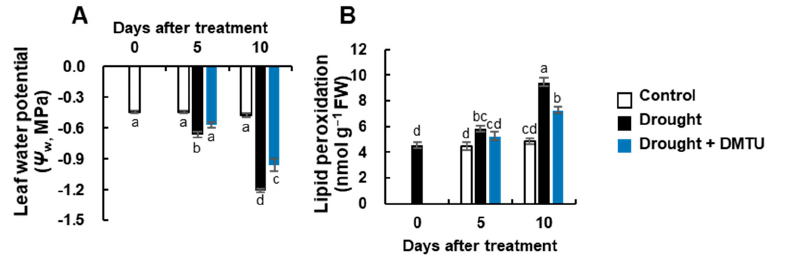
Figure 1. The changes in leaf water potential ( Ψ w , A ), and lipid peroxidation ( B ) level in the leaves of Brassica napus under control, drought, or drought with dimethylthiourea (Drought + DMTU) treatments for 10 days. Results are represented as mean ± SE for n = 3. Means with different letters are significantly different at p < 0.05, according to Duncan’s multiple range test.